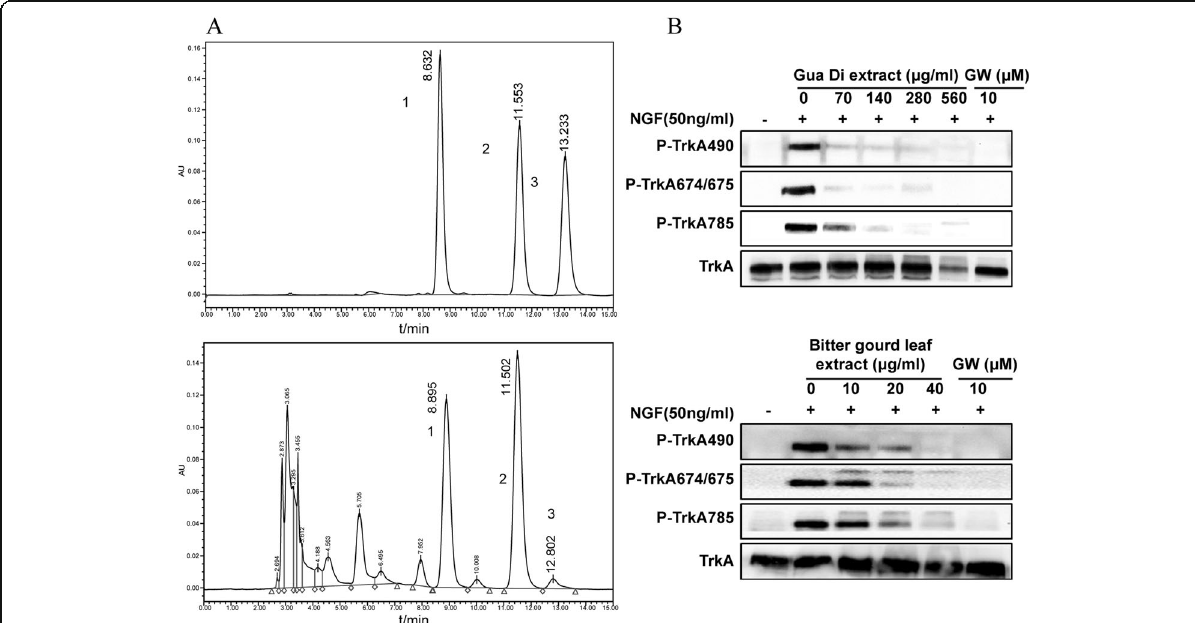
Fig. 4 Gua Di extract (GDE) and Bitter gourd leaf extract (BGLE) inhibit nerve growth factor (NGF)-mediated tropomyosin receptor kinase A (TrkA) pathway in PC12 cells. ( a ) HPLC chromatogram of three standard compounds CuI (1), CuB (2) and CuE (3) respectively (upper panel); HPLC chromatograms of extracts from GDE detected at 230 nm (lower panel). Key to peak identities: cucurbitacin I (CuI) (1); CuB (2);CuE (3); ( b ) GDE (upper panel) and BGLE (lower panel) inhibited TrkA a phosphorylation in a concentration-dependent manner as shown by western